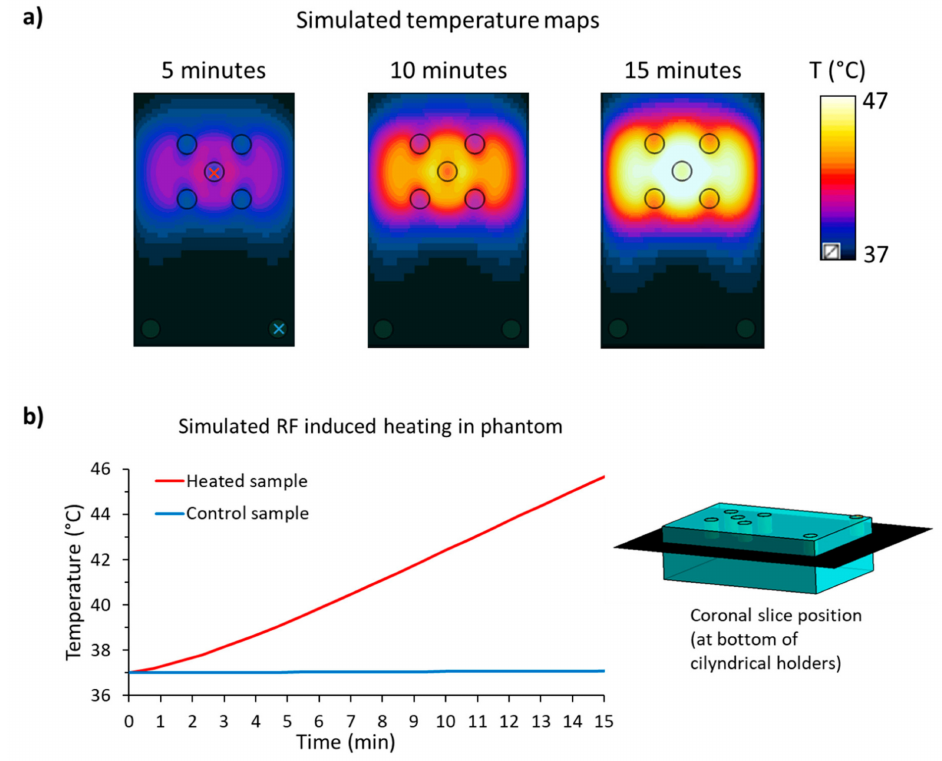
Figure 1. Simulated radio-frequency-induced heating in the phantom with P avg = 100 W for 15 min. ( a ) Simulated temperature distribution in the phantom (depth = 25 mm, coronal plane) at 5, 10, and 15 min. ( b ) Time-dependent temperature evolution in the heated sample (red line, at the red cross located in ( a )) compared to the control sample (blue line, at the blue cross located in ( a )). The schematic view of the phantom on the right-hand side shows the coronal plane where the temperature distribution maps were taken. The data show that the radio frequency (RF) heating is constrained to the central sample, while the control sample temperature profile is una ff